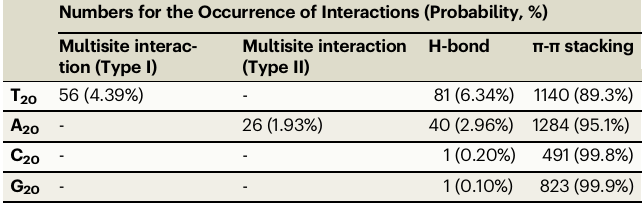
Table 1 | Summary of the intermolecular interactions between Alq 3 and DNA with different bases during the fi nal 10 ns of AA MD simulations Numbers for the Occurrence of Interactions (Probability, %)